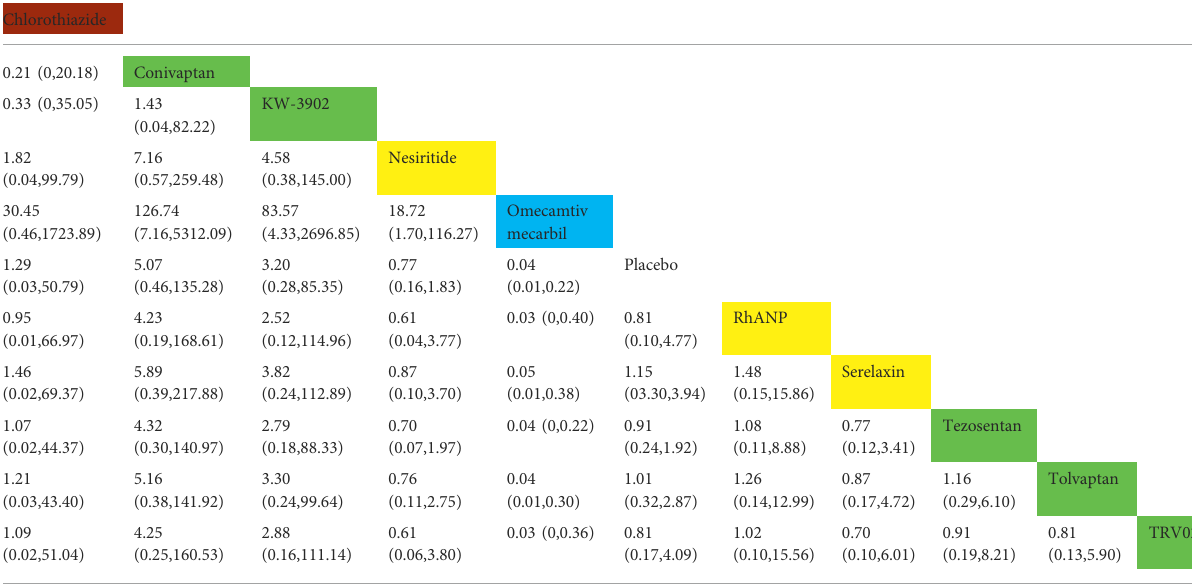
TABLE 2 Direct comparisons among different drugs of all-cause mortality within 30 days (reported as point estimates of odds ratios or weighted mean differences with 95% credible intervals, with number of studies contributing to network). Among them, those marked as red are diuretics, those marked as yellow are vasodilators, those marked as blue are cardiotonics, those marked as green are vasoconstrictors, and those marked as white are placebos. Chlorothiazide 0.21